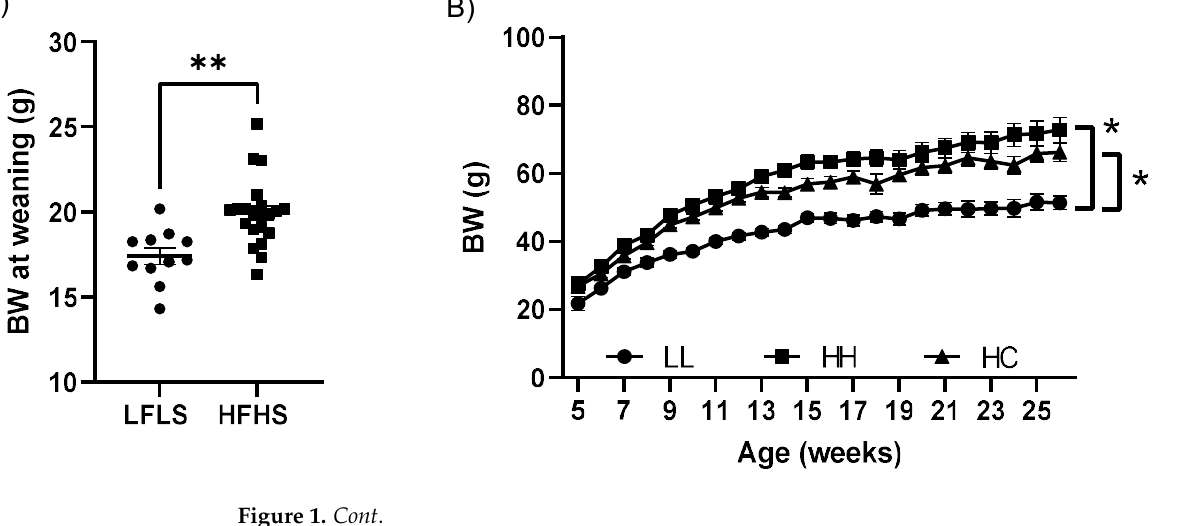
Figure 1. Physical characteristics. ( A ) BW at weaning; ( B ) BW trend over time; ( C ) Final BW; ( D ) Fat mass; and ( E ) TL in LL, HH, and HC mice. BW, Body weight; TL, Tibial length; HFHS, a high-fat and a high-sucrose diet; LFLS, a low-fat and a low-sucrose diet; LL, offspring born from maternal LFLS and postnatal LFLS indicated by closed circles (●); HH, maternal HFHS and postnatal HFHS indicated by closed squares ( ■ ); HC, maternal HFHS weaned onto a standard laboratory chow diet indicated by a closed triangle ( ▲ ). Values are expressed as mean ± SEM. * p < 0.05; ** p < 0.01; *** p < 0.001; ns, not significant. n = 6 in LL; n = 8 in HH; and n = 8–13 in HC. 2.2. Postweaning Control Diet Improved Glucose and Insulin Tolerance Tests Blood glucose levels at postnatal day 3 showed no difference between offspring born from LFLS or HFHS (100.4 ± 7.0 mg/dL, n = 11 in LFLS vs. 116.4 ± 6.2 mg/dL, n = 12 in HFHS). GTT showed that a persistent HFHS diet after weaning (HH) impaired glucose clearance when compared to LL, while switching to the control diet (HC) improved it (Figure 2A). The GTT area under the curve (AUC) was significantly higher in HH com- pared to LL, but no differences were found between LL and HC (15,434 ± 2461 in LL; 24,672 ± 2321 in HH; 18,751 ±1434 in HC) (Figure 2B). In terms of ITT, the mice in the HH group developed insulin resistance indicated by slowed glucose clearance after insulin administration and larger ITT AUC compared to LL (Figure 2C,D). In contrast, there were no differences in glucose clearance between LL and HC, indicating preservation of insulin sensitivity with a postweaning standard diet (HC) (Figure 2D). However, there was no difference between HH and HC in ITT AUC due to large animal variations (12,961 ± 1204 in LL; 21,633 ± 3790 in HH; 16,384 ± 2690 in HC). Overall, a postweaning diet resulted in improved glycemic control.